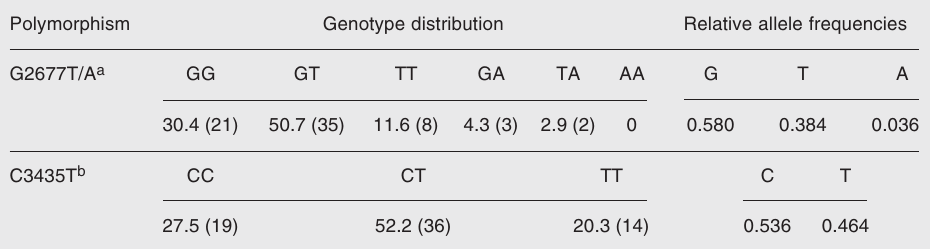
Table 2. Genotype distribution and relative allele frequency of MDR1 C3435T and G2677T/A polymorphisms in Brazilian hypercholesterolemic individuals of European